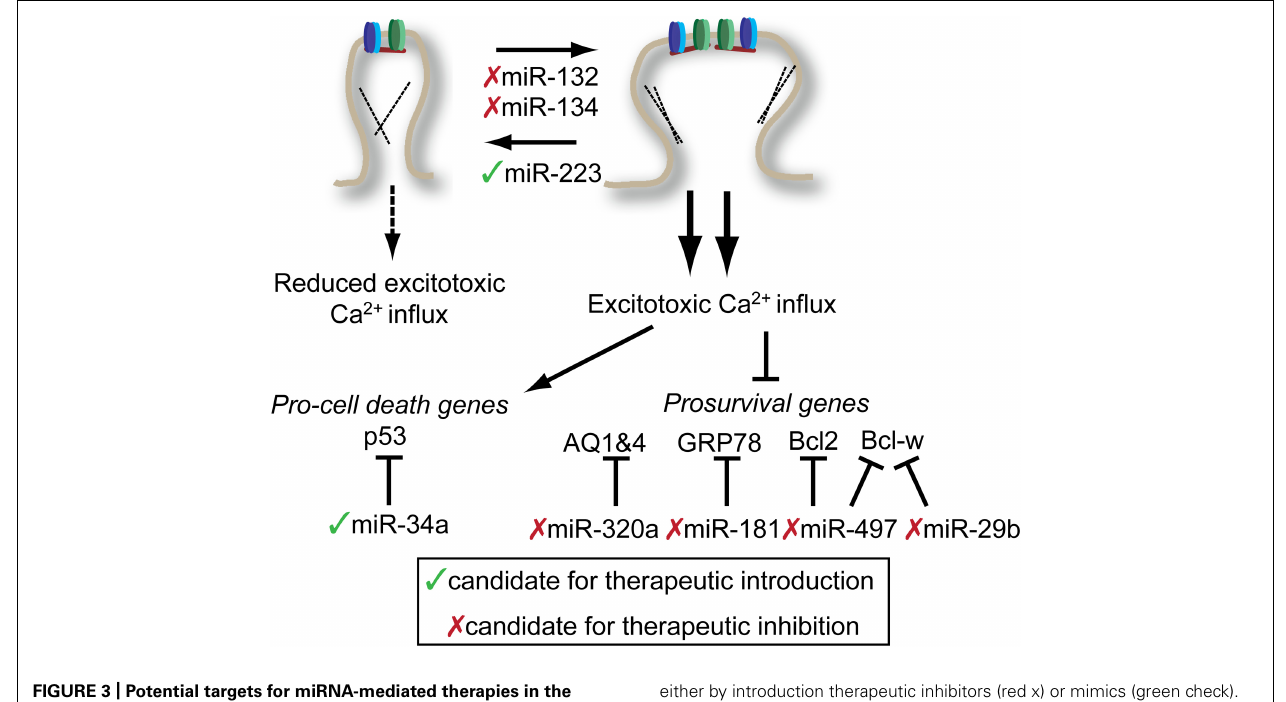
FIGURE 3 | Potential targets for miRNA-mediated therapies in the treatment of stroke and epilepsy. Potential interventions target miRNAs to either reduce excitotoxic calcium influx (top) or reduce the impact of excessive calcium influx (bottom). Potential miRNA targets and be influenced